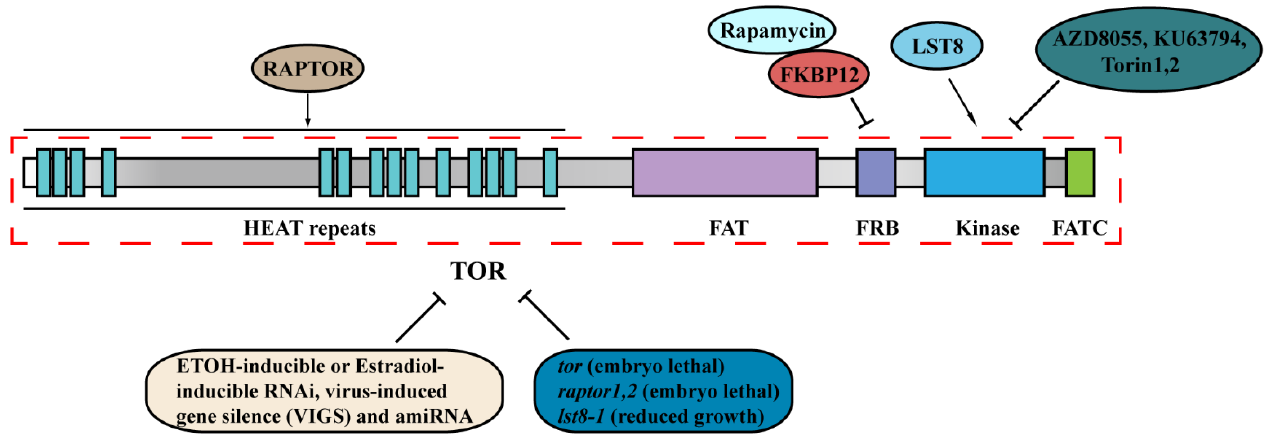
Figure 1. Structure of TOR protein and strategies to dissect TOR function. The TOR protein contains five conserved domains including HEAT repeats, FAT domain, FRB domain, kinase domain and FATC domain. The multifaceted functions of TOR kinase are dissected by integrated analysis of chemical inhibitor treatments, TOR RNAi seedlings and TOR signaling-related mutants. Abbreviations: TOR, Target of Rapamycin; HEAT repeats, Huntingtin, Elongation factor 3, subunit of protein phosphatase 2A and TOR1; FAT, FRAP, ATM and TRRAP domain; FRB, FKP12-rapamycin binding domain; FATC, Carboxy-terminal FAT domain; RAPTOR, regulatory-associated protein of mTOR; LST8, lethal with Sec13 protein 8; FKBP12, FK506-binding protein 12; RNAi, RNA interference; amiRNA, artificial microRNA.